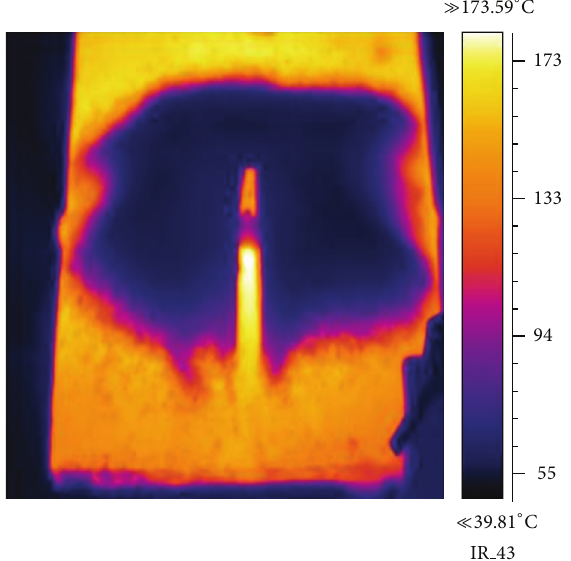
Figure 16: Thermogram of the upper face of the plate at time 𝑡 = 315